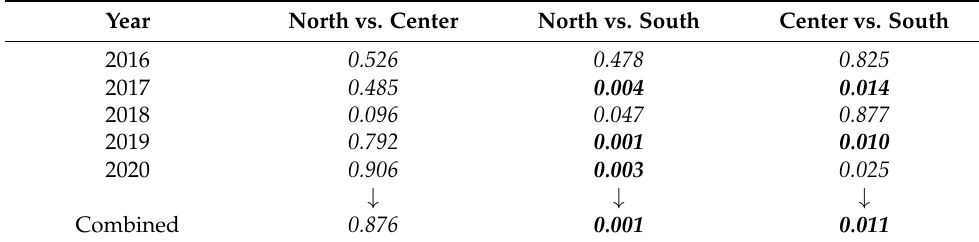
Table 2. Partial and combined p -values of two-by-two comparison between macro-areas, stratifying for year, for only SA.